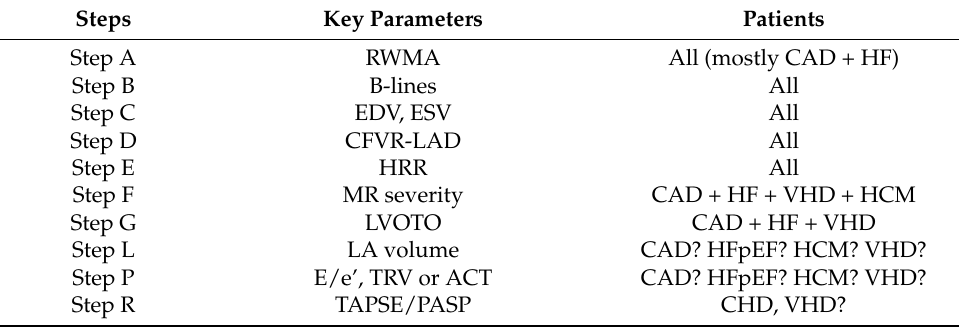
Table 3. ABCDE-FGLPR Steps, specific parameters, target